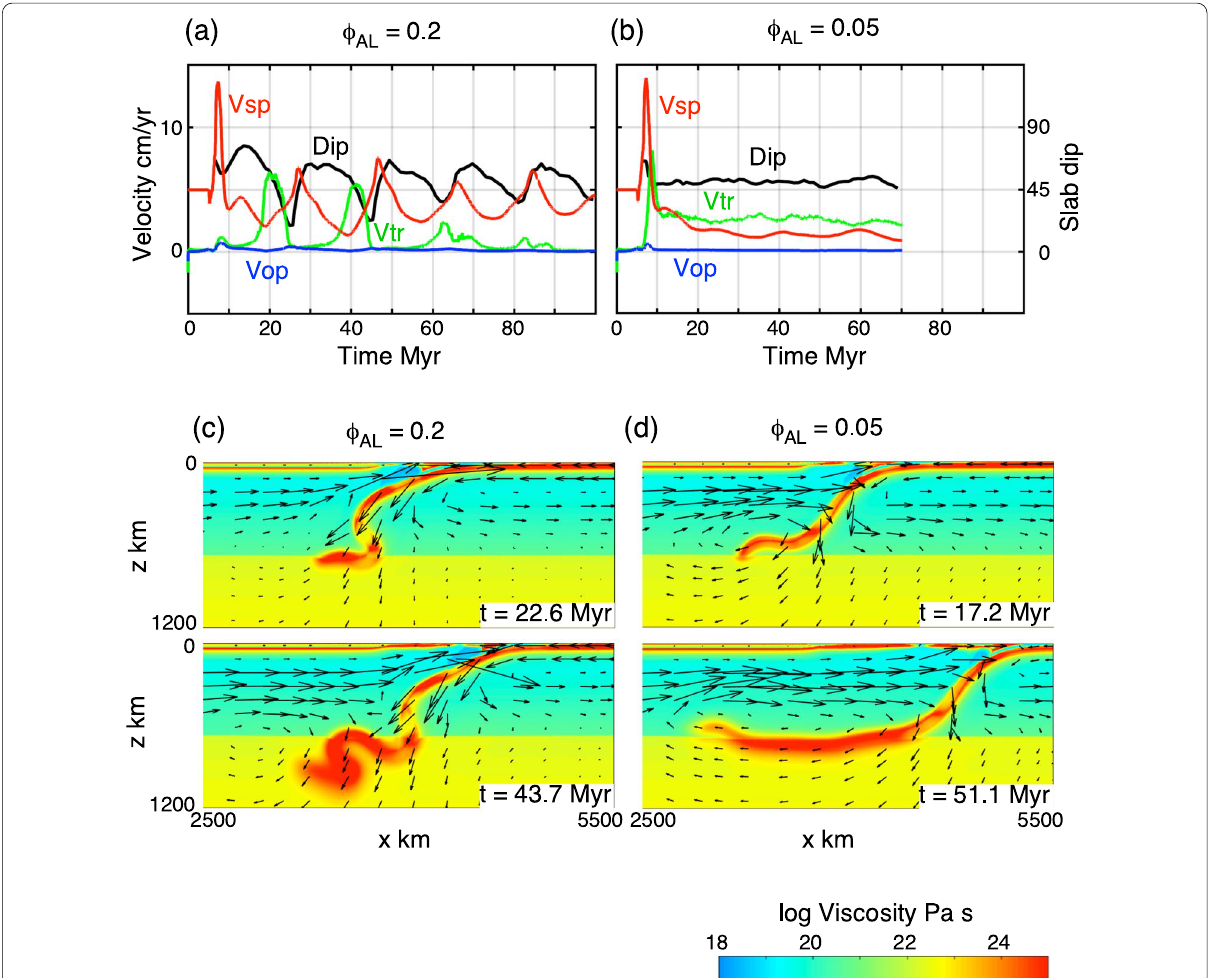
Fig. 6 Results for case 7 a , c with φ AL subducting plate ( V sp ), the overriding plate ( V op ) and the trench ( V tr ) combined with the average dip angle of the slab surface (Dip) measured in the depth range of 200–300 km. c , d Slab geometries. The distribution of effective viscosity is shown by different colors and arrows indicate the velocity